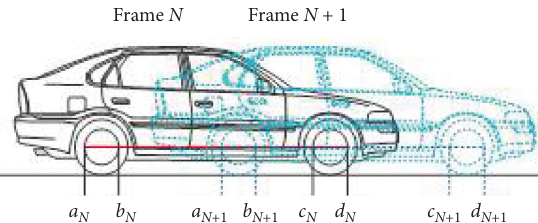
Figure 2: Distance calibration between adjacent image sequences.